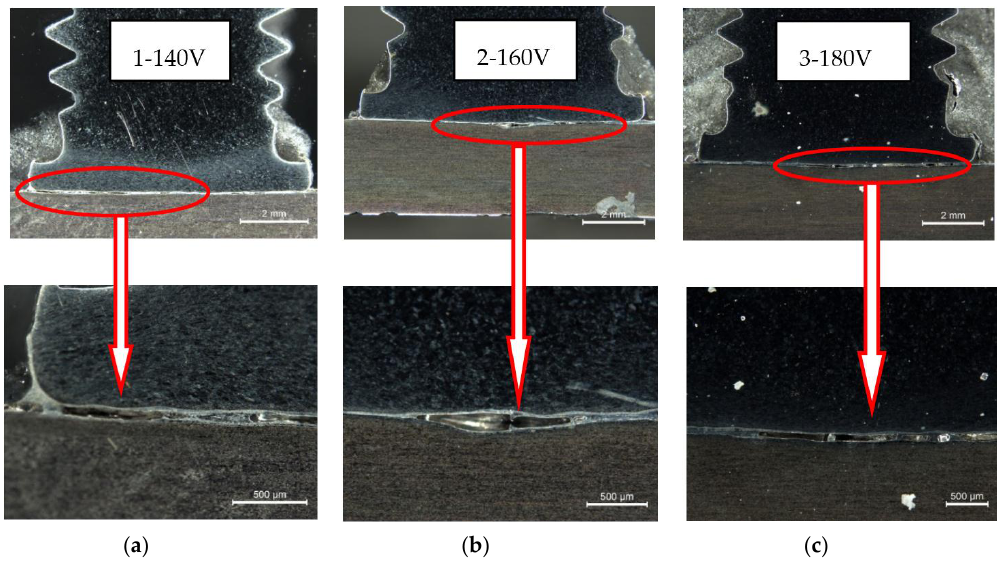
Figure 9. Unwelded zones and voids in macro-structure images of samples: ( a ) 1-140 V, ( b ) 2-160 V, and ( c ) 3-180 V.